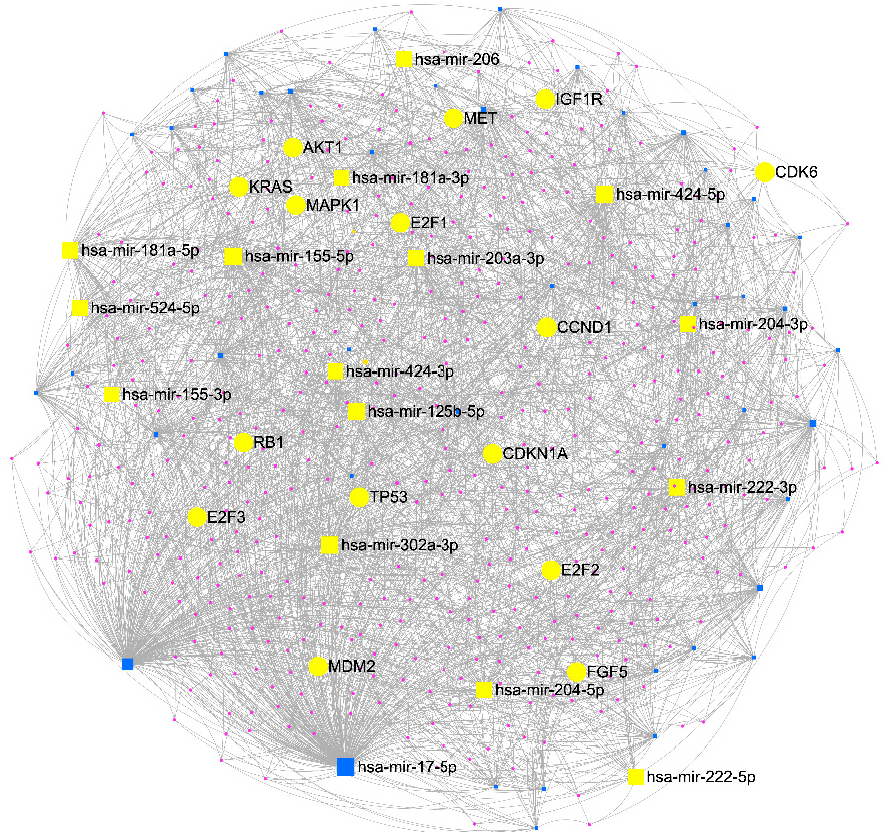
Figure 2. miRNA network analysis interaction with genes in CMM melanoma. The miRNA-target gene interaction network containing 550 nodes and 2619 edges. Squares indicate miRNA examples, yellow squares indicate miRNAs related to melanoma and yellow circles are the interacting genes in melanoma. The visualization was performed using miRNet 2.0 [60].